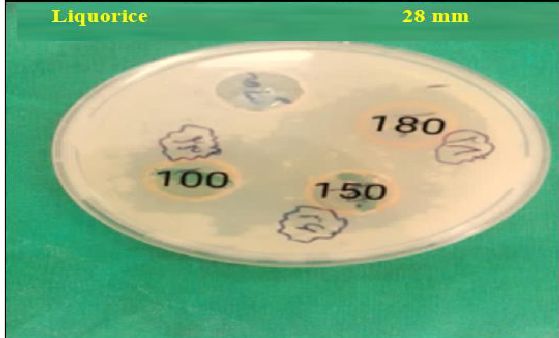
Fig. 1. Results of inoculation of Glycyrrhiza glabra extract in Pseudomonas aeruginosa